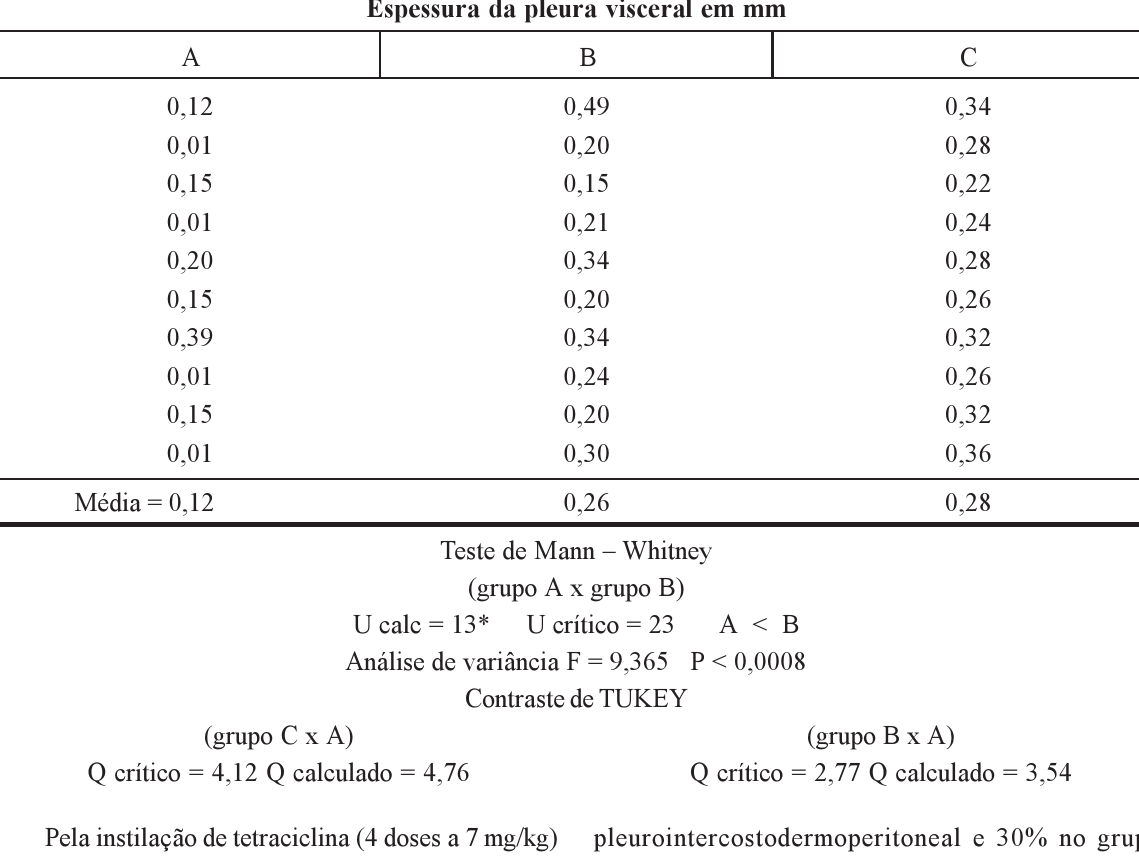
pleurointercostodermoperitoneal e 30% no grupo simula(cid:231)ªo (Tabela 3).